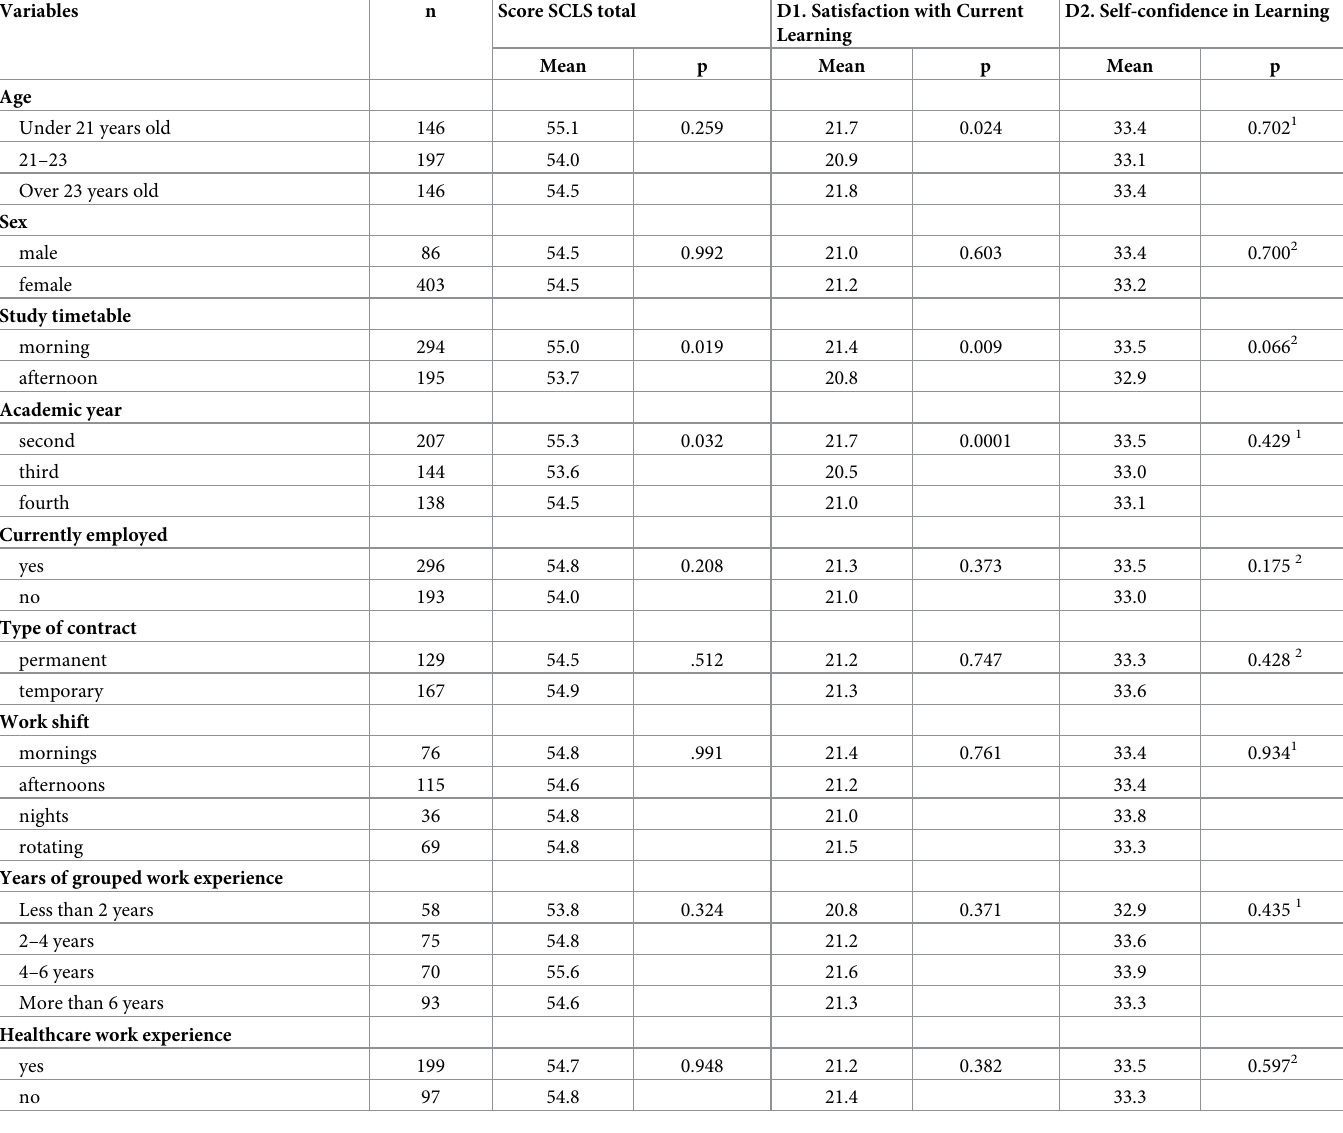
Table 6. Satisfaction and self-confidence of clinical simulation with respect to socio-demographic